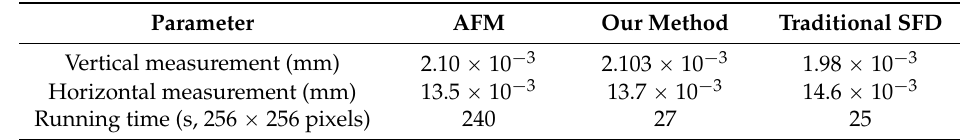
Table 1. Performance of our 3D reconstruction